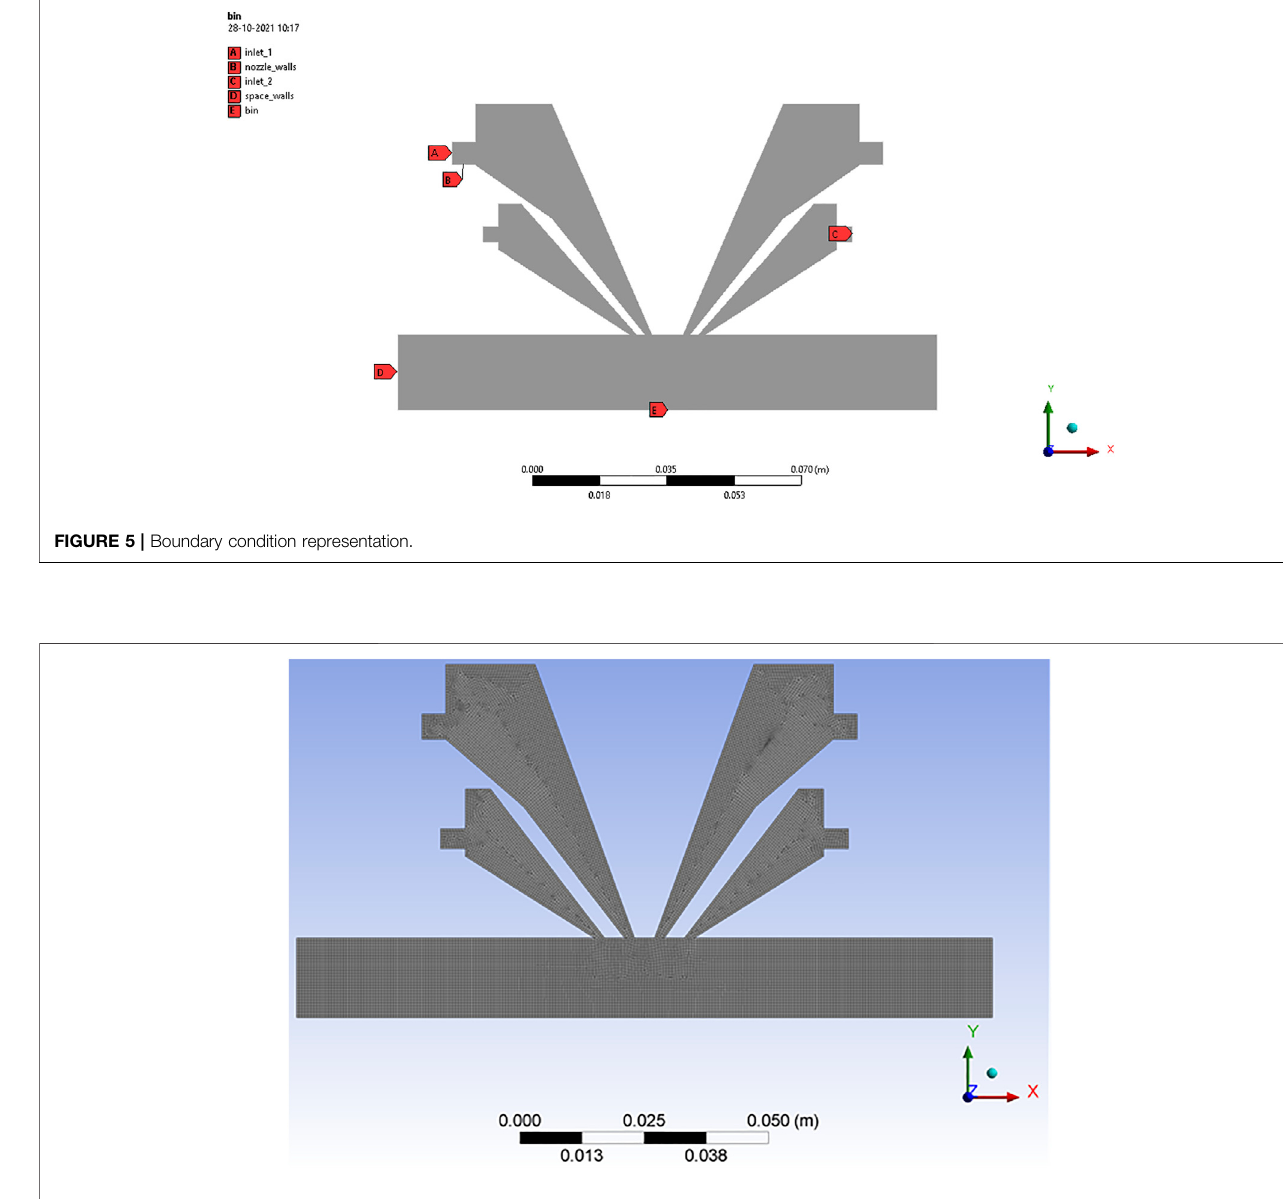
FIGURE 6 | Meshing of 2D